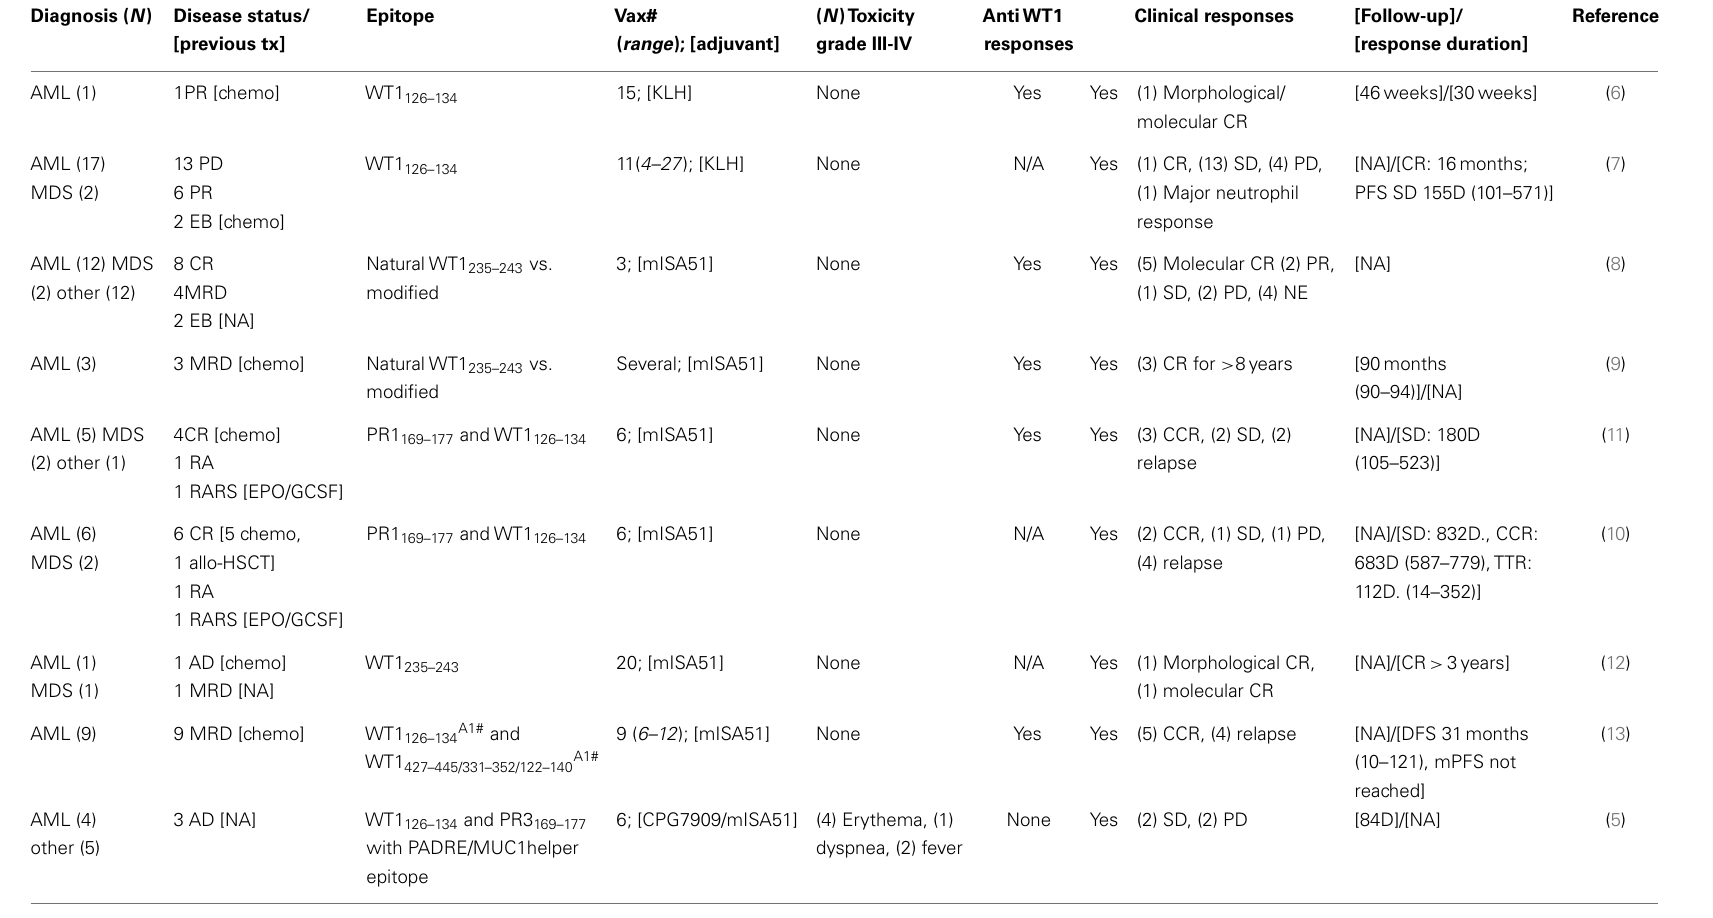
Table 2 | Summary of reviewed clinical trials . Diagnosis ( N ) Disease